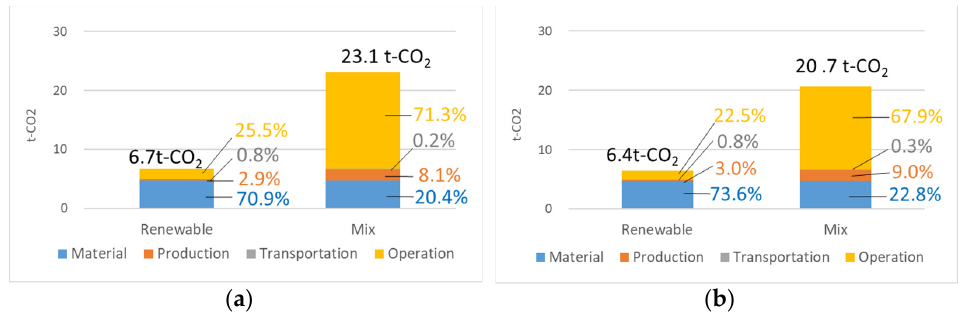
Figure 4. Total CO 2 emissions considering battery degradation ( a ) with degradation; ( b ) without Figure degradation.